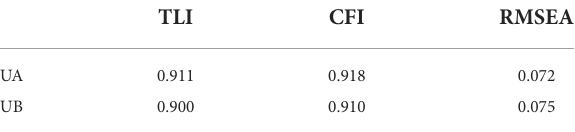
TABLE 4 Model fit